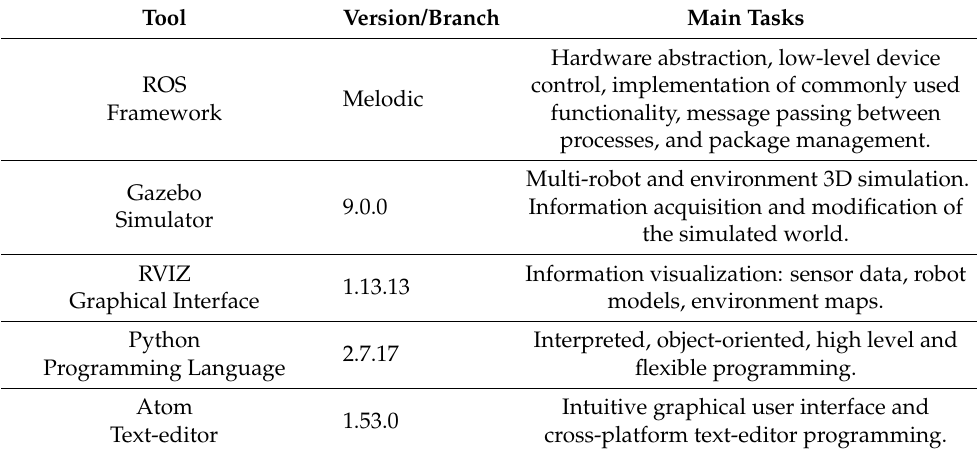
Table 1. Main tools for experimentation.